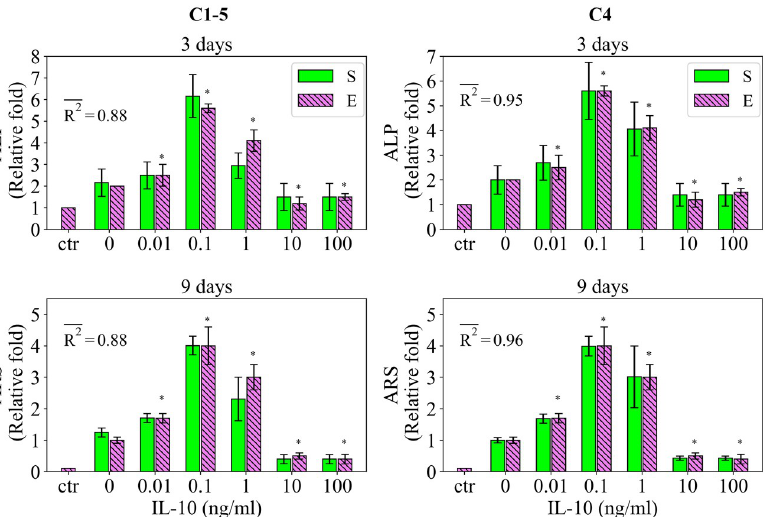
Fig 6. Fits of the model calibrated by C1-5 and C4 to the empirical data of study 4. Bars indicate the simulations (S) and the corresponding empirical data (E). The quantities of ALP and ARS are reported at day 3 and 9, respectively. The data is presented in a relative fold compared to the control, i.e. the undifferentiated case encoded as ctr. The error bars on the empirical data shows the standard deviations. The error bars on the simulation results show the standard deviations obtained during SSIP, i.e. 15% alteration in the estimated parameter values. Stars indicate the statistically significant differences between values given for the empirical data compared to the control (p < 0.05 = � ). R 2 is the average fitness value of the simulations for the given measurement